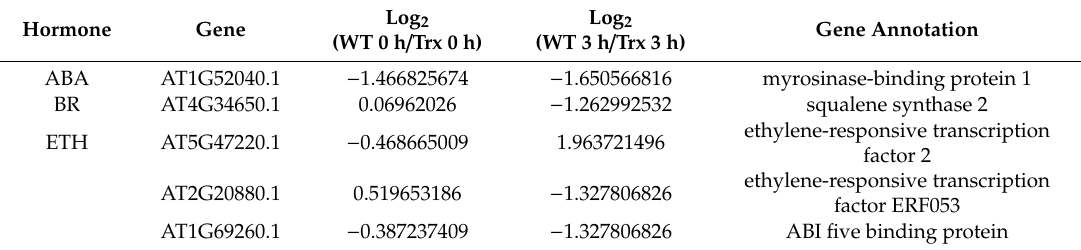
Table 2. Expression analysis of DEGs involved in hormone synthesis and signal transduction pathways during salt stress exposure.